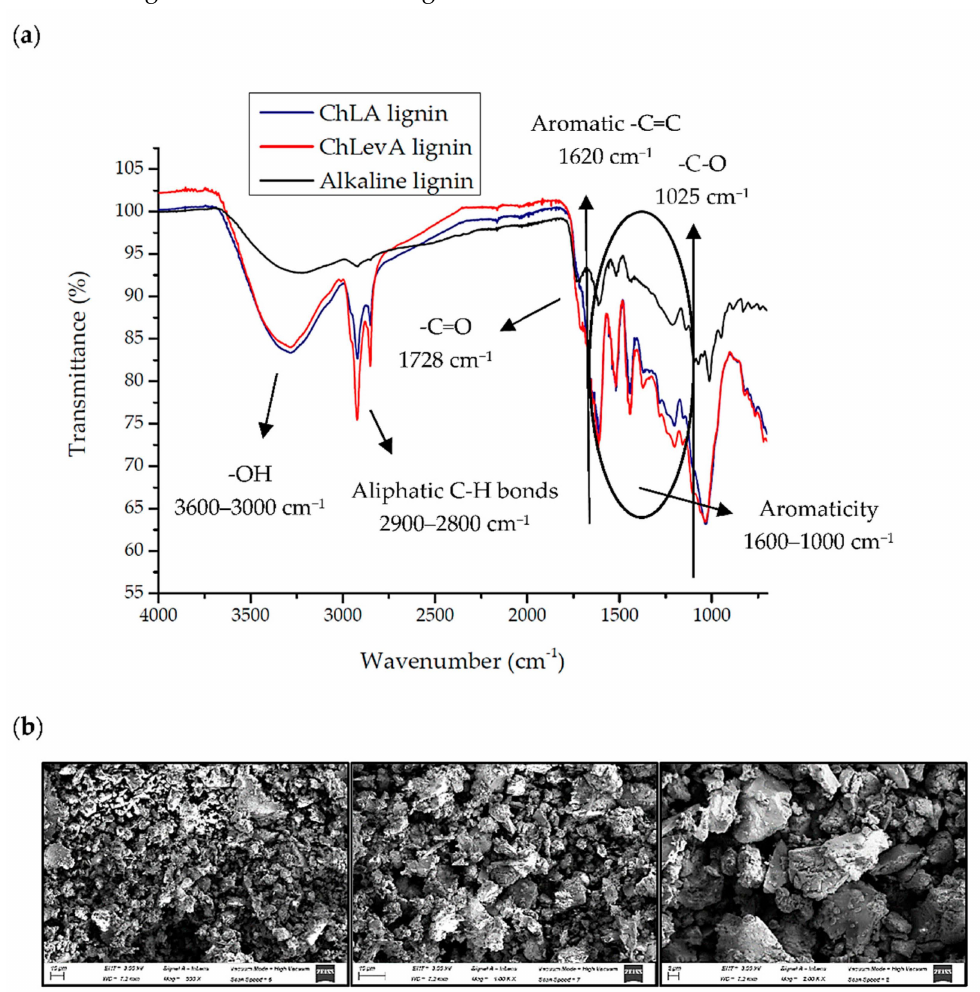
Figure 3. FT-IR spectra for NaDES and alkali lignin ( a ); and SEM images at 500 × , 1.00 K × , and 2.00 K × magnification for alkali lignin ( b